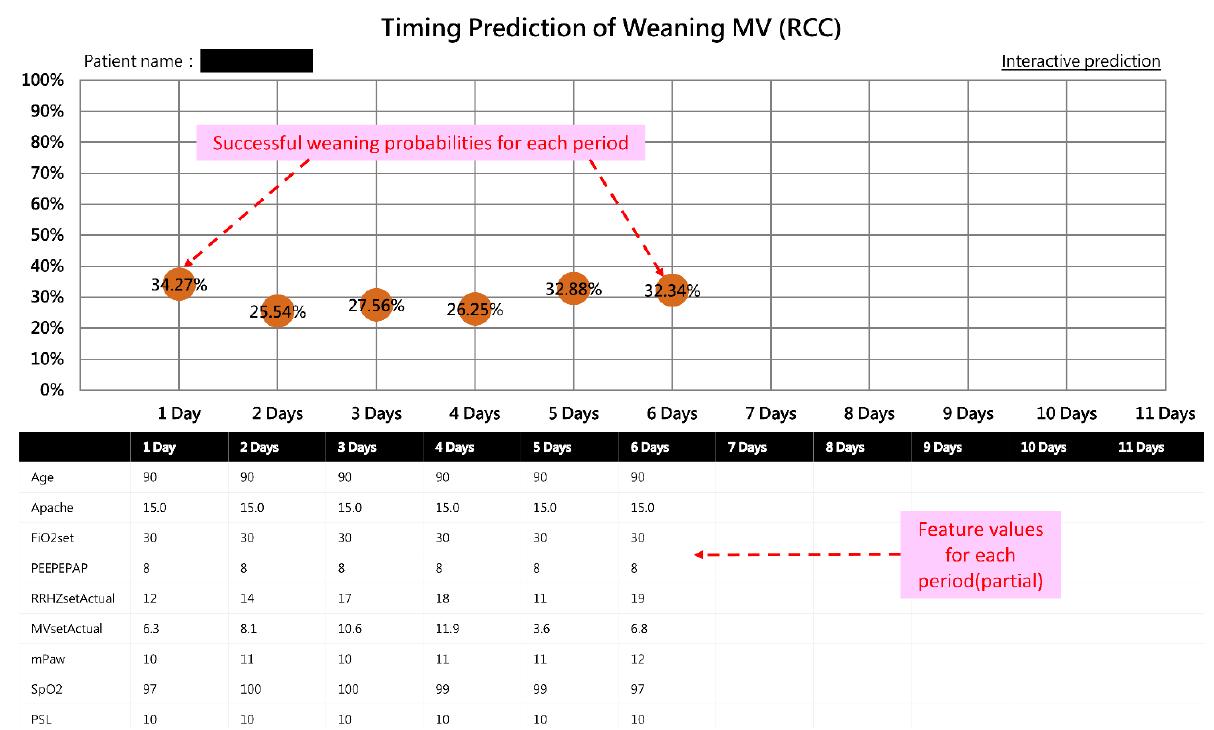
Figure 4. A screenshot of a specific patient’s curve chart of successful weaning probability.